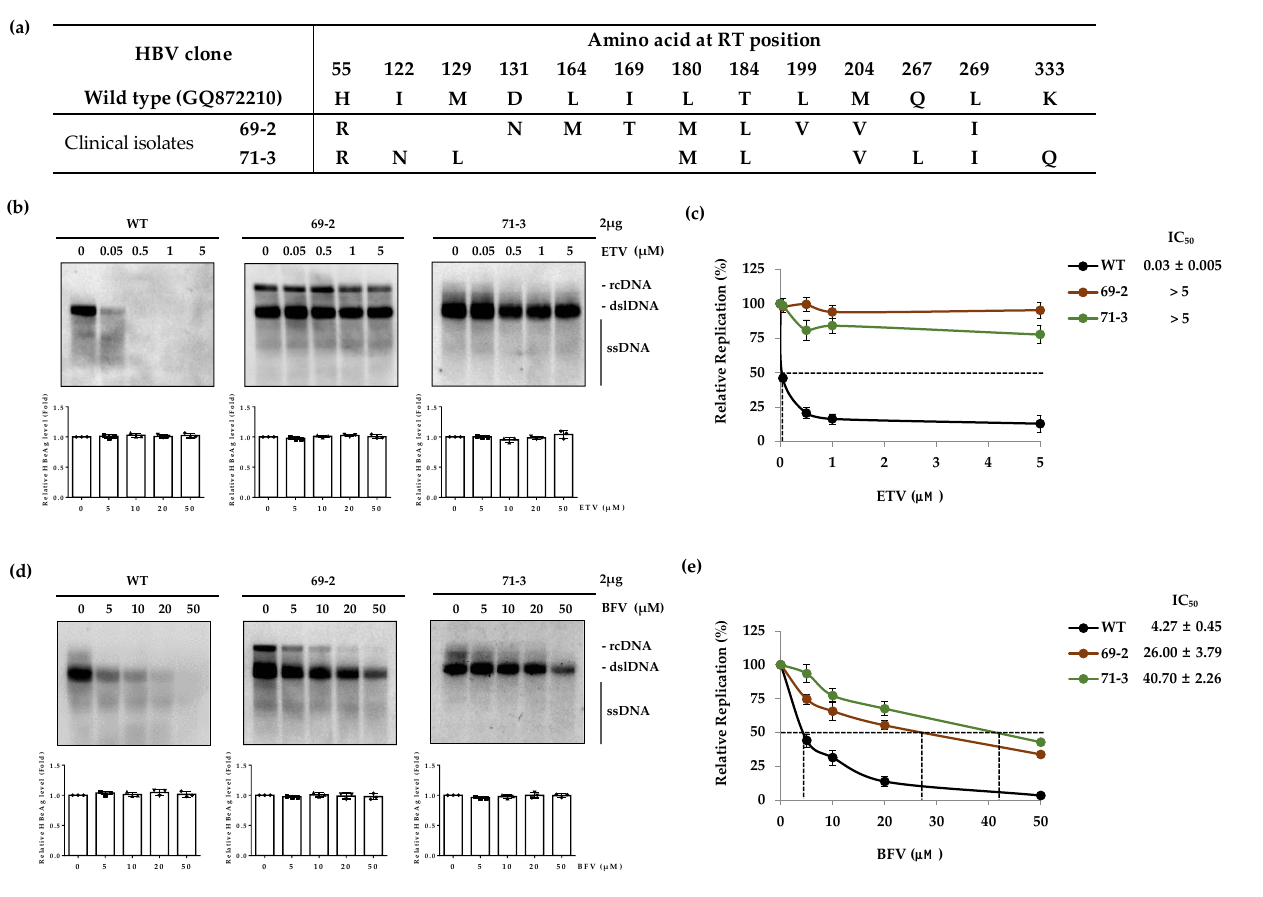
Figure 3. In vitro BFV susceptibility assay for ETV-resistant HBV clones. ( a ) The sequence of clinical isolates with ETV-resistant mutations. ( b , top panels) To analyze the susceptibility of mutants to ADV, clones were transfected into the Huh7 cells and ETV was treated for 4 days in a dose-dependent manner. HBV replication level was measured by Southern blot. ( c ) The IC 50 values for patient-derived clones were compared to WT. ( d , top panels) The HBV DNA replication of ETV-resistant clones, treated with BFV for 4 days, was determined by Southern blot. ( e ) The IC 50 of BFV for WT and ETV-resistant HBV clones. ( b , d , bottom panels) Secreted HBeAg into supernatant was assessed. Data in ( b – e ) were obtained from at least three independent experiments (mean ± SD). BFV, besifovir; ETV, entecavir.